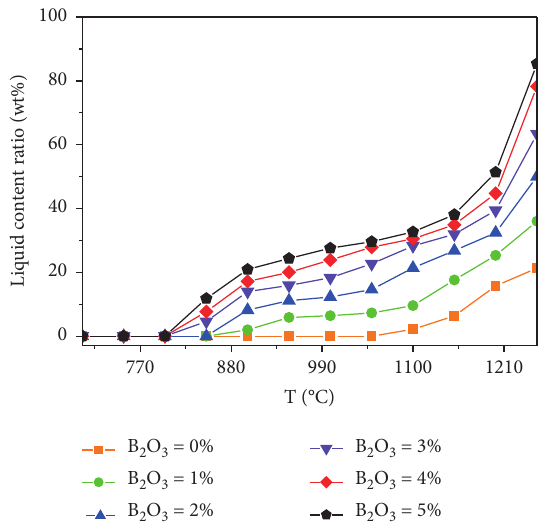
Figure 6: The volume of liquid phase with different B